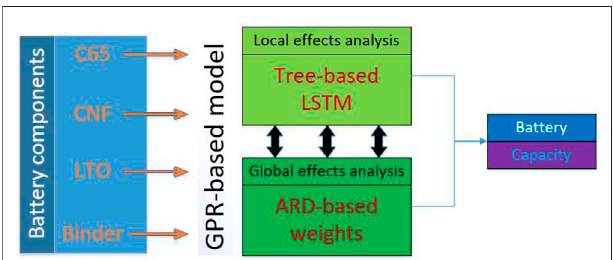
FIGURE 2 | Hybrid data-driven method structure to predict battery capacities and analyze both global and local effects of component